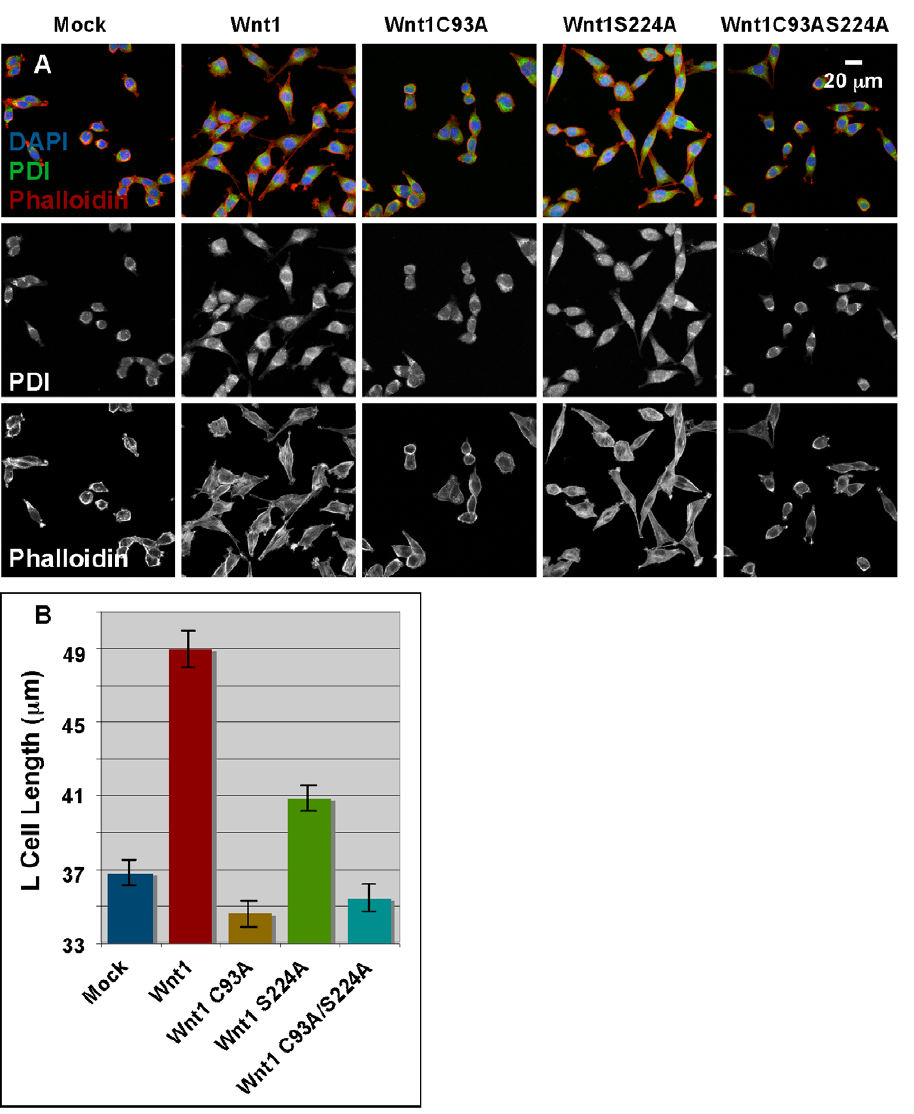
Figure 7. Wnt1 C93 is more critical than S224 for ß-catenin independent signaling in L cells. Panel A: L cells stably transfected with vector alone (mock), Wnt1, Wnt1C93A, Wnt1S224A, or Wnt1C93AS224A were stained with DAPI to visualize nuclei, anti-PDI to detect Protein Disulfide Isomerase and Phalloidin to detect Actin. Confocal images are shown (blue=DAPI; green=PDI; red=phalloidin). A scale bar is also shown for reference. Fluorescence in the DAPI channel was used to randomly select fields of view for imaging analysis. Panel B: The length of the long axis of PDI-stained cells was measured and graphed. A Student’s t-test shows that the elongation of cells stably transfected with Wnt1 and Wnt1 S224A is statistically significant (p , 1 6 10 2 9 ) as compared to mock-transfected cells while that of Wnt C93A and Wnt1 C93AS224A is not (p . 0.3). 6 independent replicates with at least 21 total fields and 470 total cells were measured. Error bars show standard error.